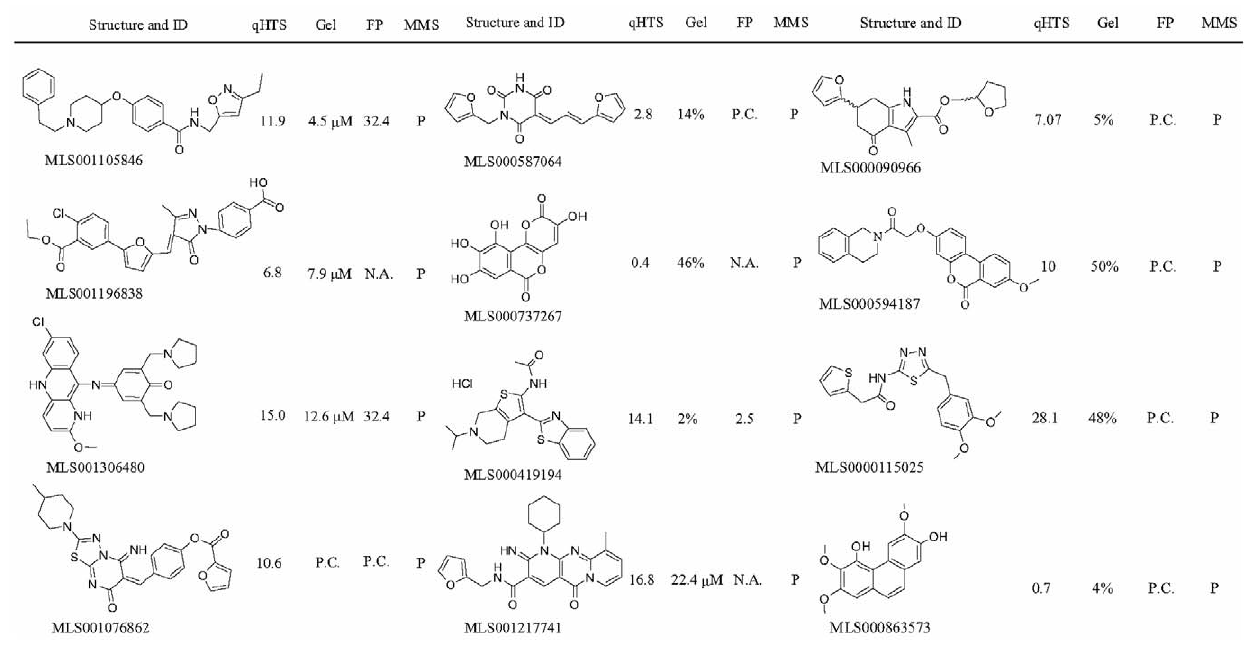
Figure 7. Screening hits showing significant activity in the MMS cytotoxicity enhancement experiments. qHTS, IC 50 ( m M) obtained in the initial quantitative high-throughput screen; Gel, percent incision observed in the presence of 100 m M compound using the radiotracer detection or estimated IC 50 value ( m M) using the fluorescence detection; FP, IC 50 ( m M) or annotation of response (N.A., no activity observed; P.C., partial concentration response curve) obtained in the fluorescence polarization displacement assay; MMS, potentiation of the genotoxic effect of methylmethane sulfonate (P, positive).